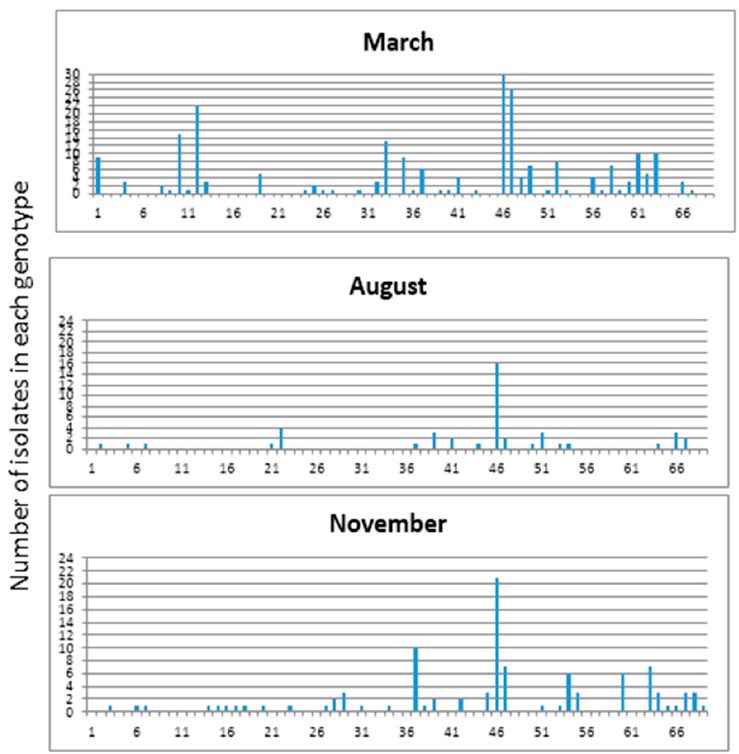
Figure 6. Temporal variations of E. coli isolates based on rep-PCR analysis in wetland for March, August, and November.